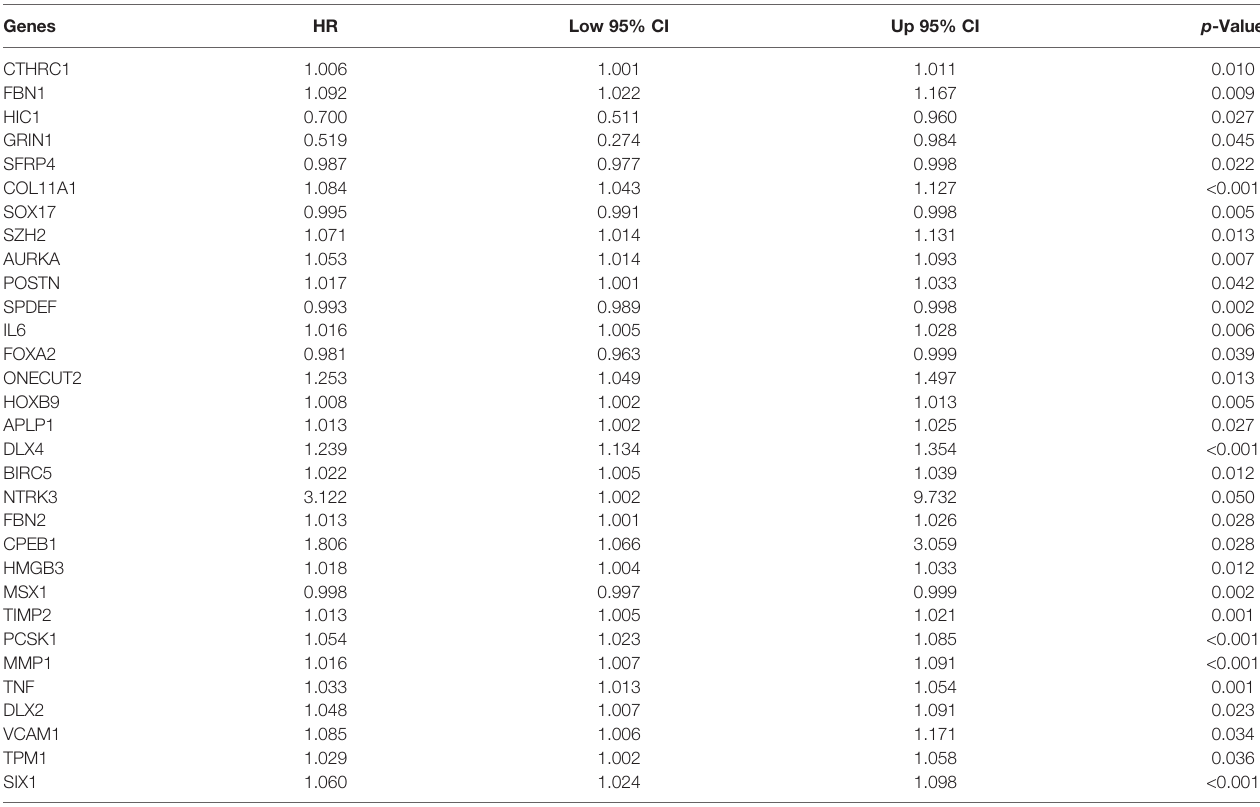
TABLE 1 | Univariate Cox regression analysis of 31 EMT-related genes in EC in the training set. Genes HR